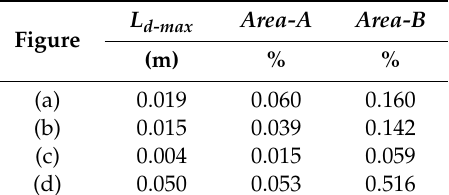
Figure 8. Simulation model: ( a ) Schematic diagram of ABAQUS simulation model; ( b ) ABAQUS simulation model. Table 1. Parameters used to evaluate the results of Figure 9.